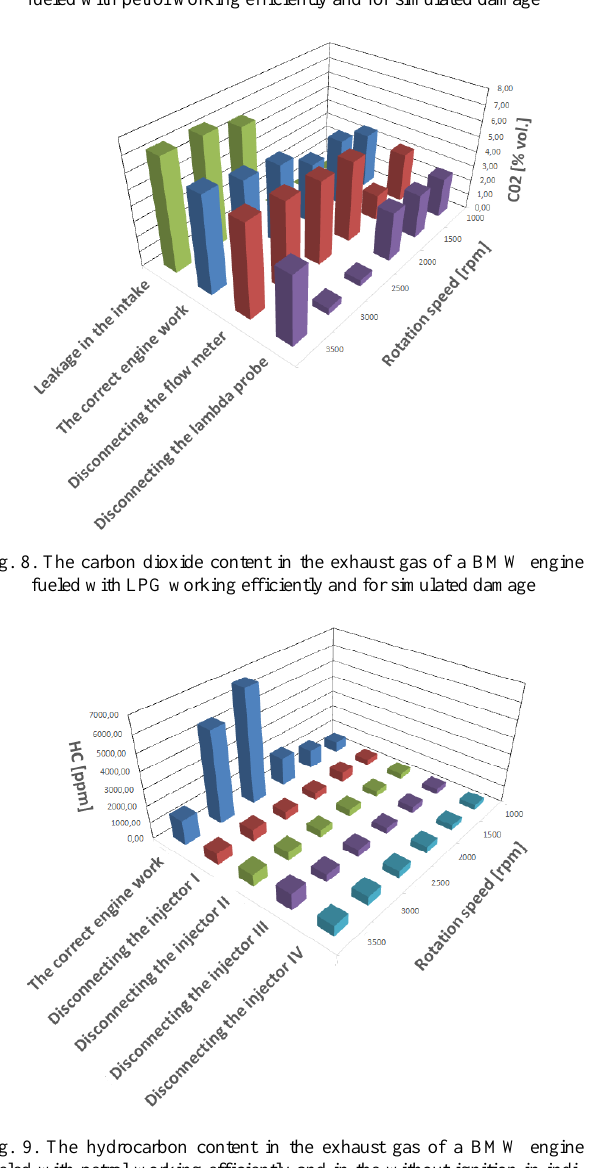
Fig. 7. The carbon dioxide content in the exhaust gas of a BMW engine fueled with petrol working efficiently and for simulated damage